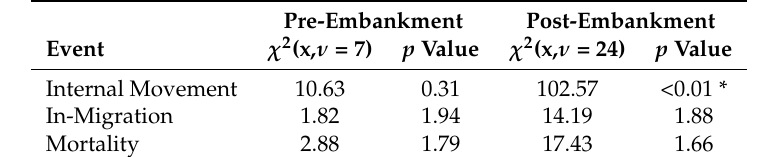
Table 2. Comparison of event rates within each (pre/post) embankment period based on GP-based. Here, χ 2 ( ν = 7, p = 0.01) = 1.24, and χ 2 ( ν = 24, p = 0.01) = 10.86. The ∗ symbol denotes the event rates are significantly different with p -value less than 0.01.